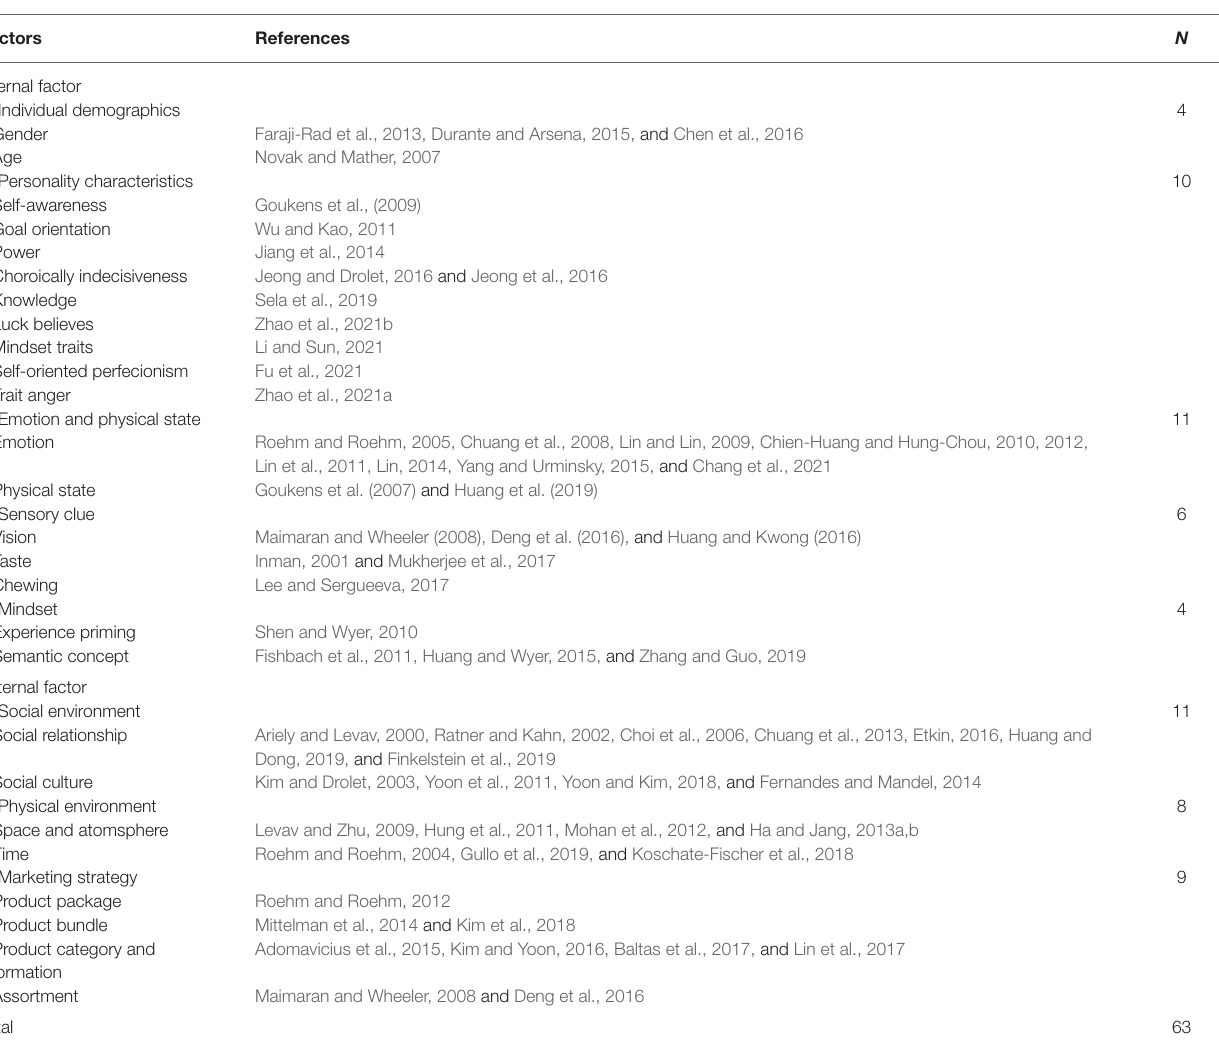
TABLE 1 | Factors investigated in variety-seeking bahavior in